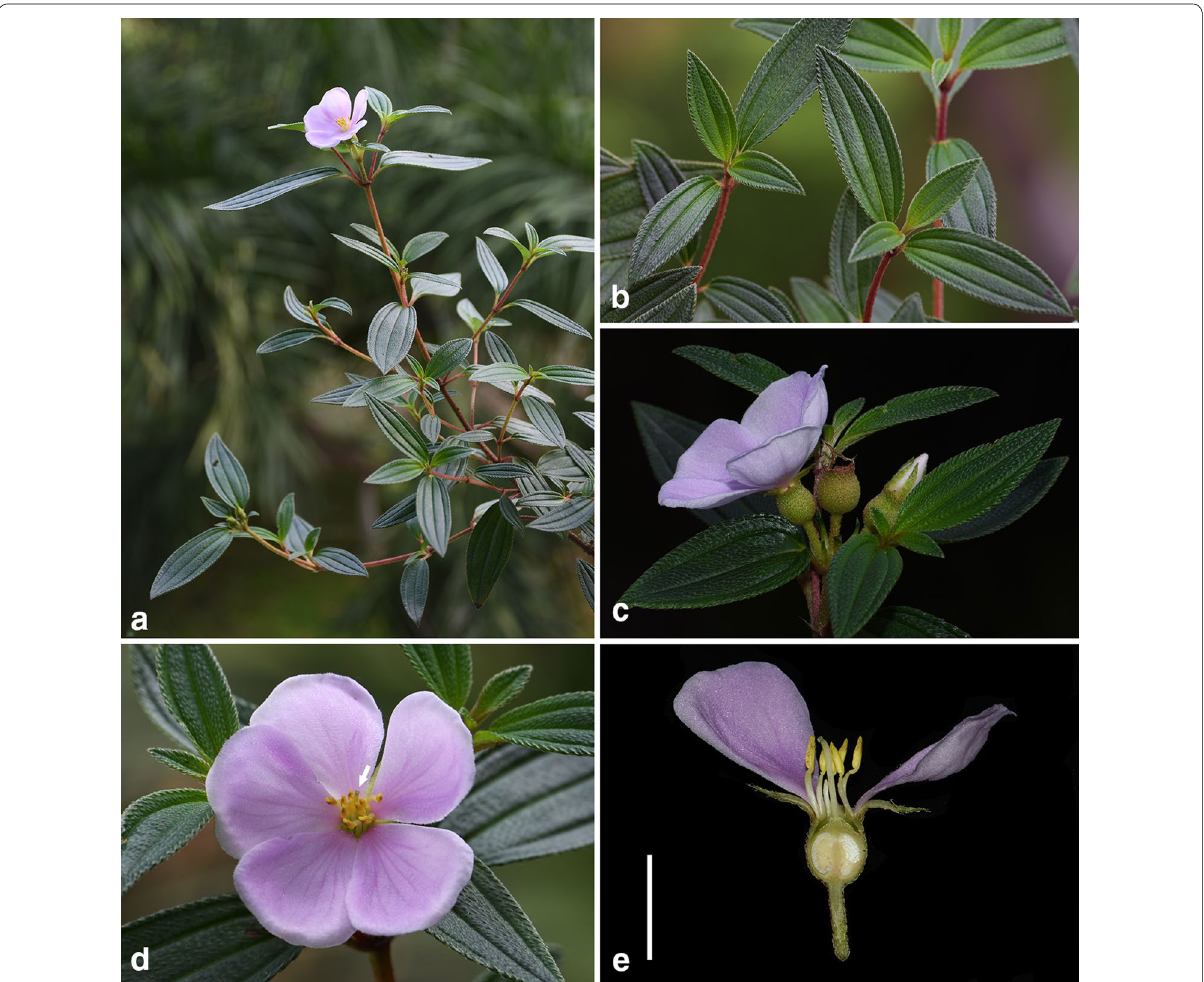
Fig. 9 Otanthera scaberrima (Hayata) Ohwi. a Habit; b leaves; c inflorescence; d flower, arrow indicated the position of stigma; e longitudinal section of a flower, scale bar 10